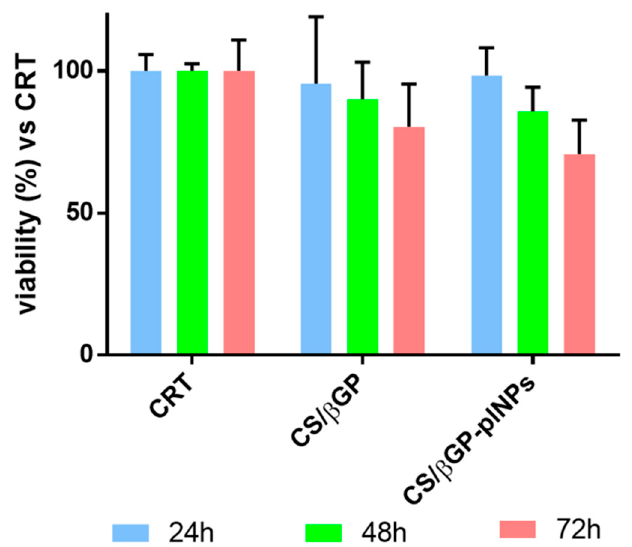
Figure 9. Cytotoxicity of CS- β GP and CS- β GP-plNPs evaluated after incubation for 24, 48 and 72 h with HDFs. Results are presented as mean ± sd ( n = 3, independent experiment). Tukey ′ s multiple comparison reveals no significant differences. CRT is untreated cell used and used as control.